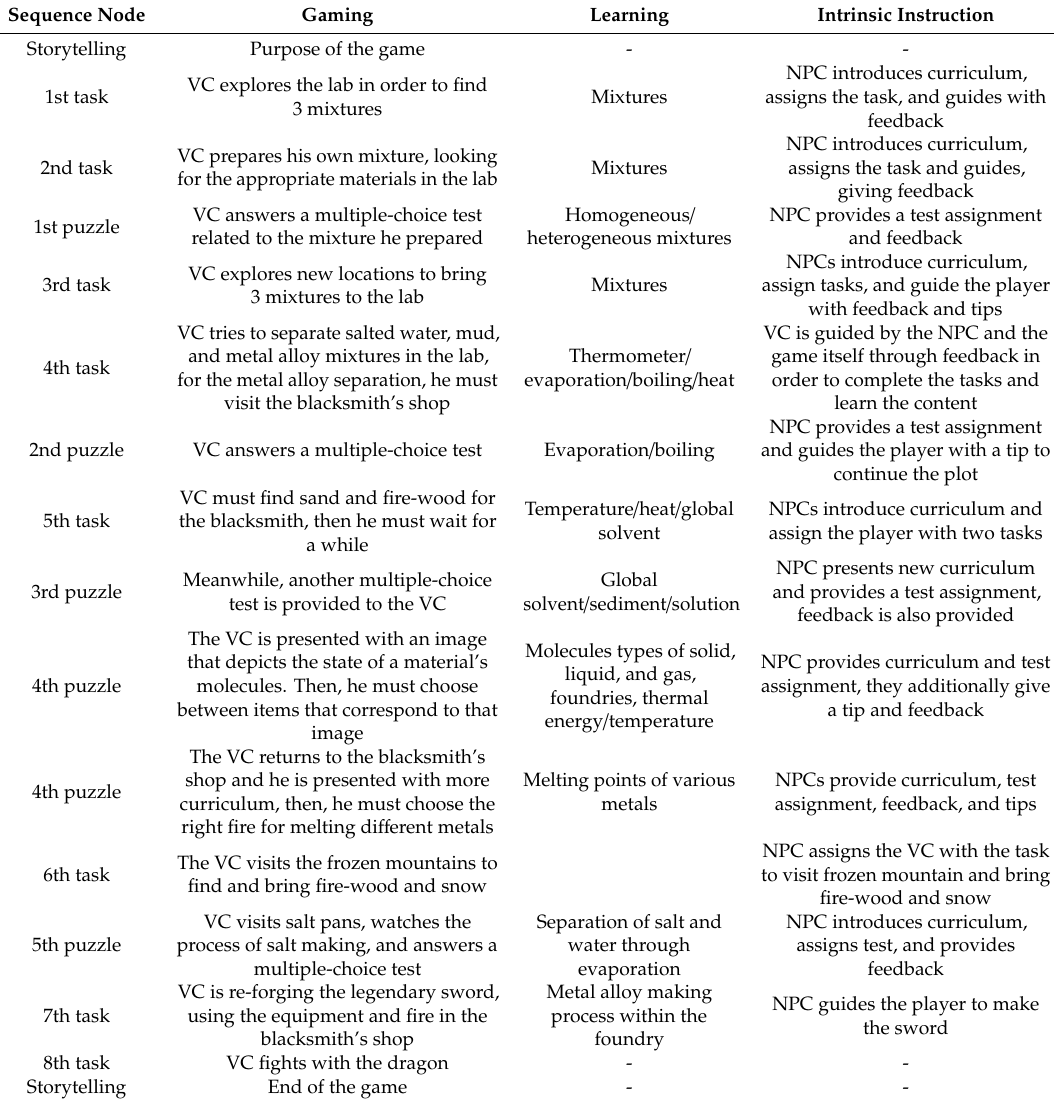
Table 3. Description of the CRPG’s